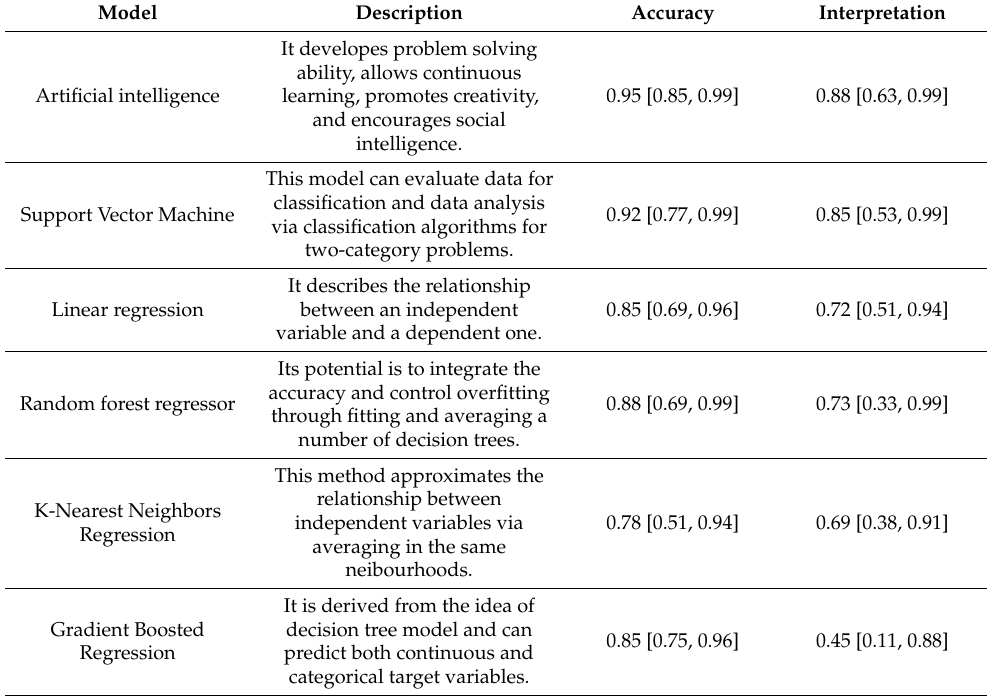
Table 2. The common models used in Python